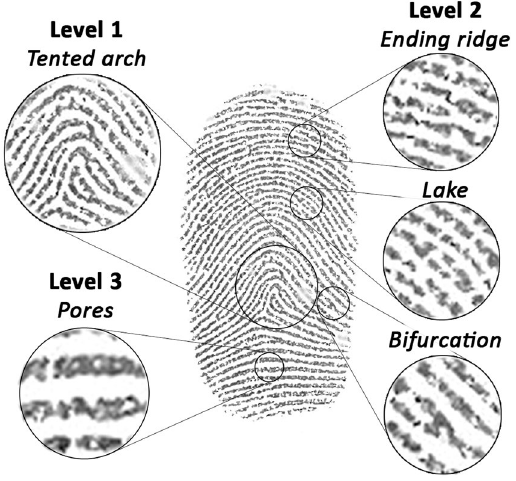
Figure 1. Inked fingermark taken from the primary donor within this research article. Examples of fingermark ridge characteristics have been indicated, including; Level 1 (class of mark - tented arch), Level 2 ( minutiae - ending ridge, lake and bifurcation) and Level 3